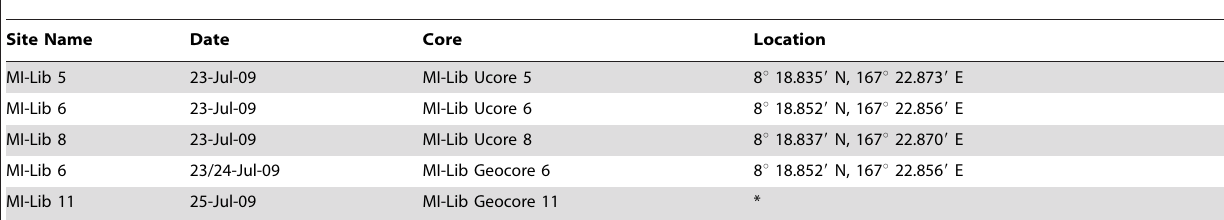
Table 4. Collected Lib Pond Sediment